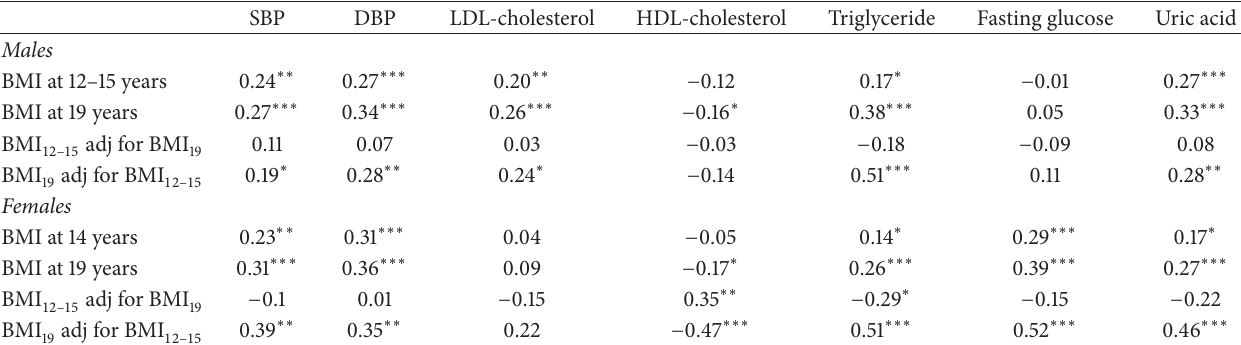
Table 4: Standardized linear regression coefficients for the associations between cardiometabolic risk factors at the age of 19-20 years and body mass index measured at the age of 12–15 years or at the age of 19-20